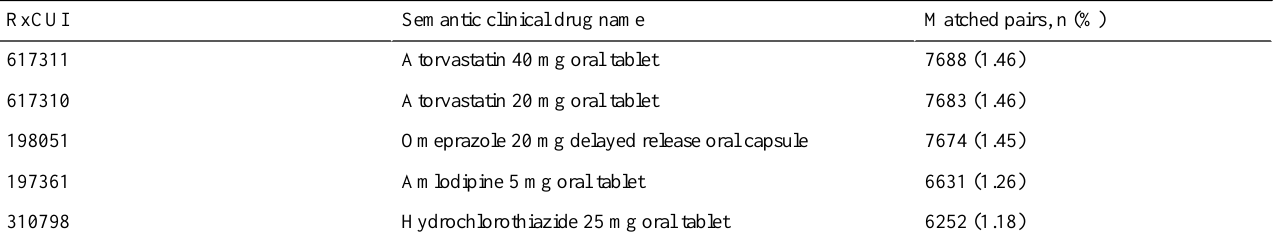
Table 1. Five most frequently found clinical drug packs in the analyzed dataset (N=527,881).